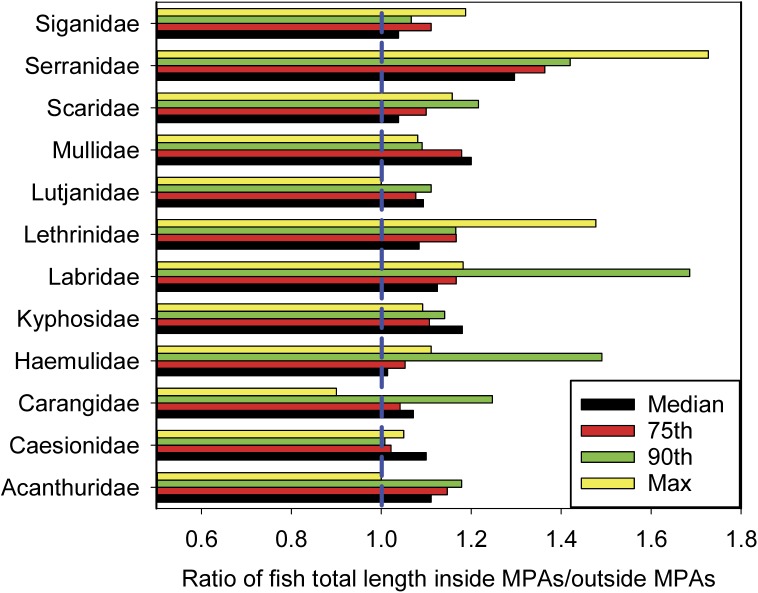
Ratio of fish lengths (TL) by family inside versus outside MPAs based on median, 75th and 90th percentiles, and maximum size.